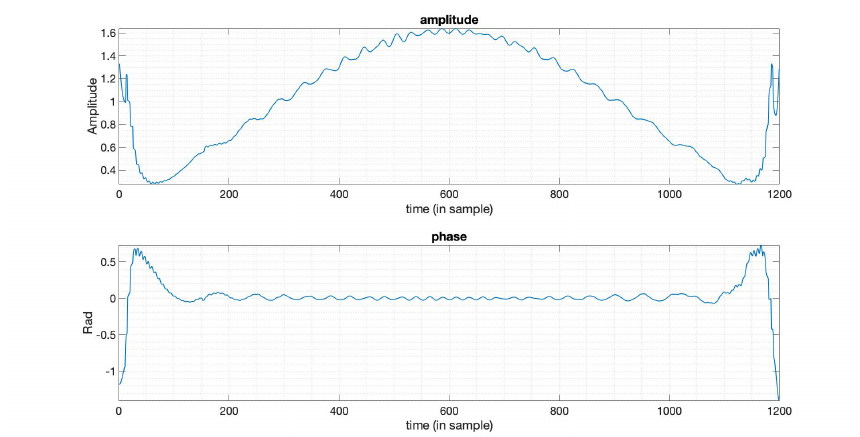
Figure 8. The amplitude and phase of the optimized window function in Figure